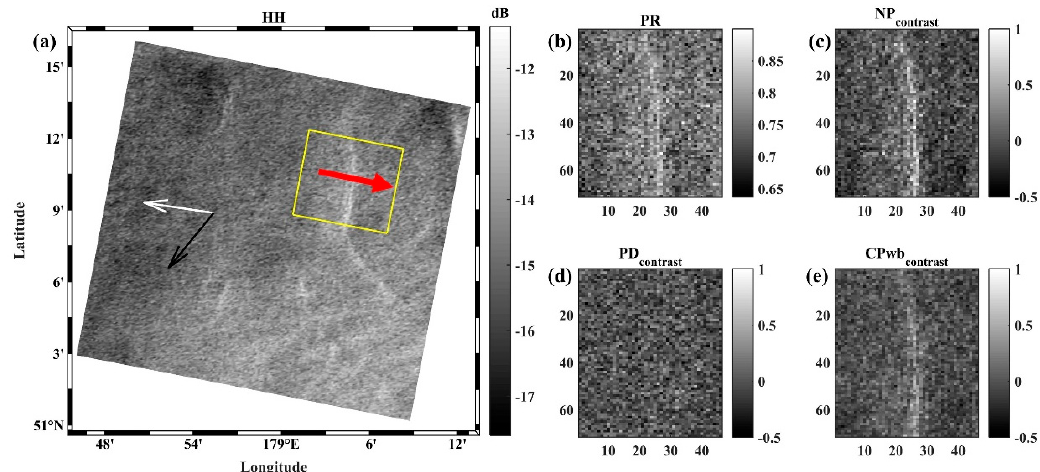
Figure 11. SAR images containing ocean current features: ( a ) RS-2 SAR HH-polarized images (dB units) of an area of the Aleutian Islands acquired at 18:20 UTC on September 14, 2009. The key parameters associated with the enlarged region of the yellow fragment in ( a ) are estimated as: ( b ) PR (linear units); ( c ) NP contrast; ( d ) PD contrast, and ( e ) CPwb contrast. The incidence angle, averaged wind speed and the angle between radar look direction and wind direction are about 34 degrees, 10 m / s and 60 degree, respectively. RS-2 data are a product of MacDonald, Dettwiler, and Associates, Ltd. All rights reserved.